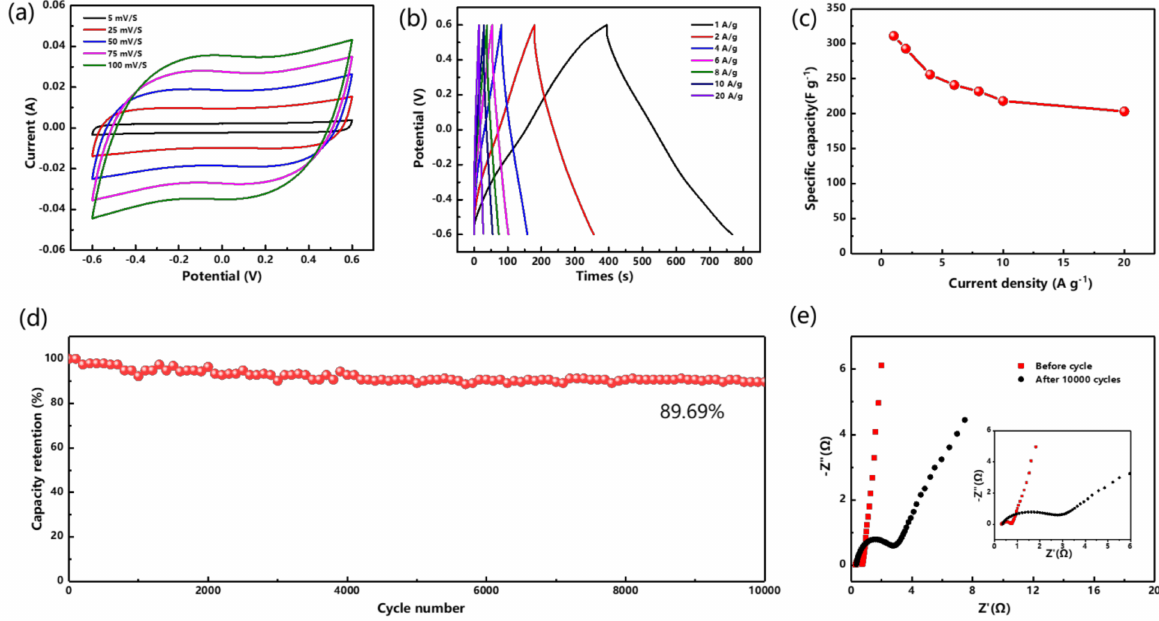
Figure 6. ( a ) CV curves of the device at different scan rates ranging from 5 to 100 mV s − 1 . ( b ) GCD curves of the device at different current densities ranging from 1 to 20 A g − 1 . ( c ) Specific capacitances of the device at different current densities. ( d ) Cycling performance at a current density of 10 A g − 1 for 10,000 cycles. ( e ) Nyquist plot of the device before and after cycles (inset is the plot in the high − frequency